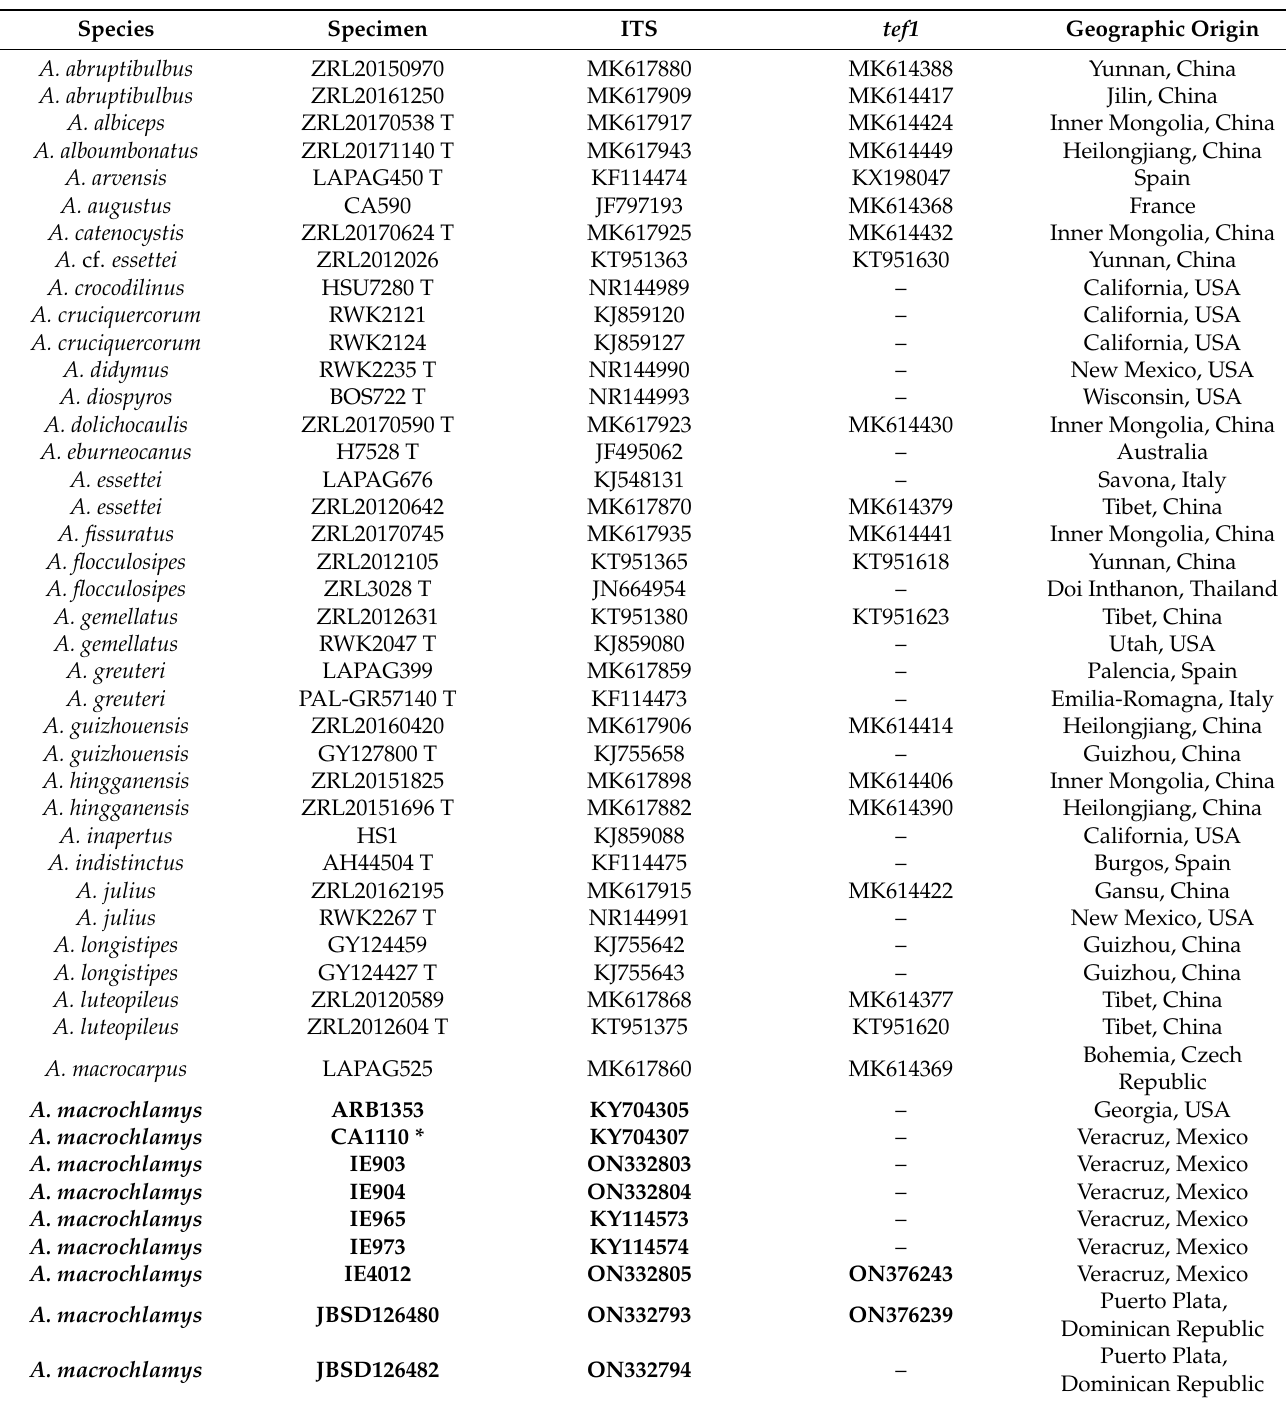
Table 1. GenBank accession numbers and specimens used in the phylogenetic analyses. New species, new specimens, and new sequences are in bold. T = Type specimen. * CA1110 is the strain isolation of the holotype. ** A. fiardii , a new synonym of A. subrufescens introduced in this